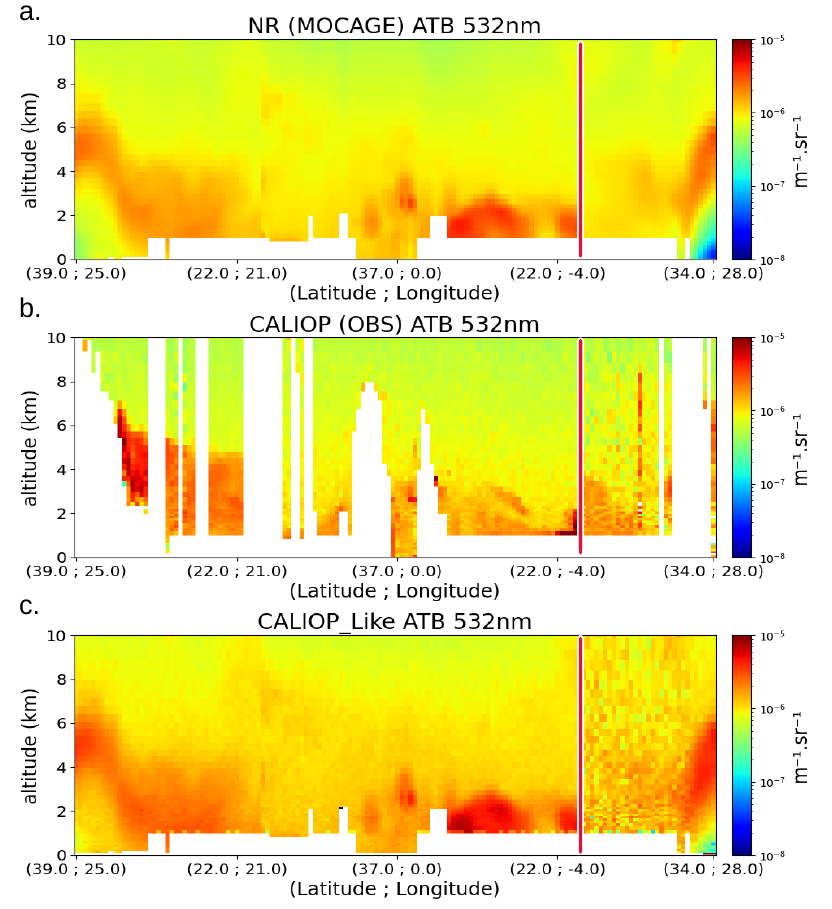
Figure 4. Comparison of ATB transects at 532 nm along the trajectory of CALIOP for 22 March 2018 over the Medit region. ( a ) Transect from the NR, ( b ) CALIOP observations, and ( c ) the corresponding CALIOP_Like SO. The vertical red line corresponds to the start of the daytime orbit